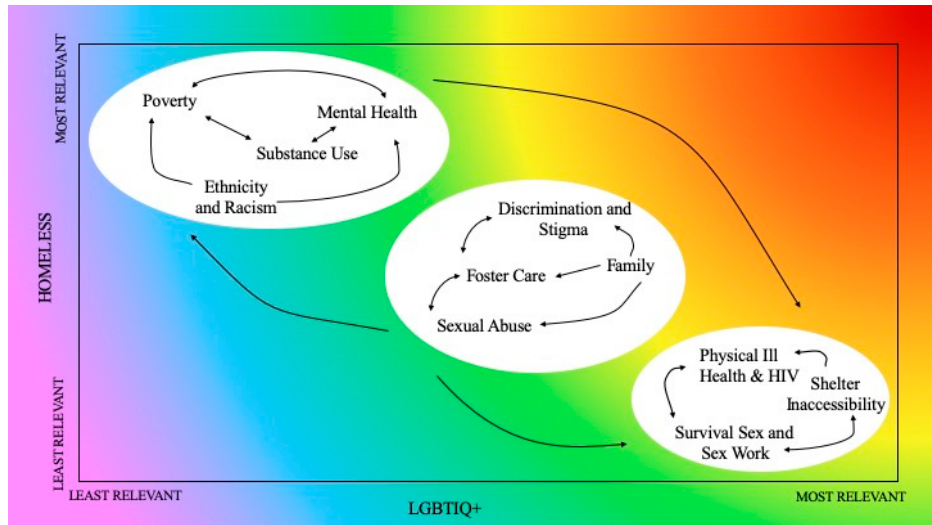
Figure 1. Intersections of LGBTIQ + Identity and Experiences of Homelessness. The groupings from left to right are; proximate causes of homelessness, systems failures in early life, and experiences during homelessness.